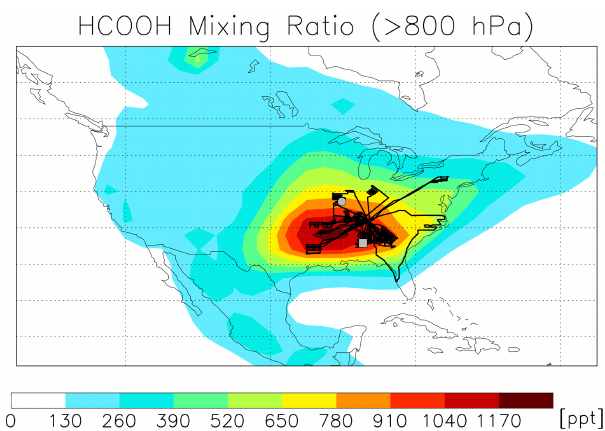
Figure 2. HCOOH mixing ratios in the summertime boundary layer as simulated by GEOS-Chem. Plotted is the June–September mean for P > 800hPa. Also shown are the SENEX flight tracks (in black) and the SOAS and SLAQRS ground site locations (grey square and circle,